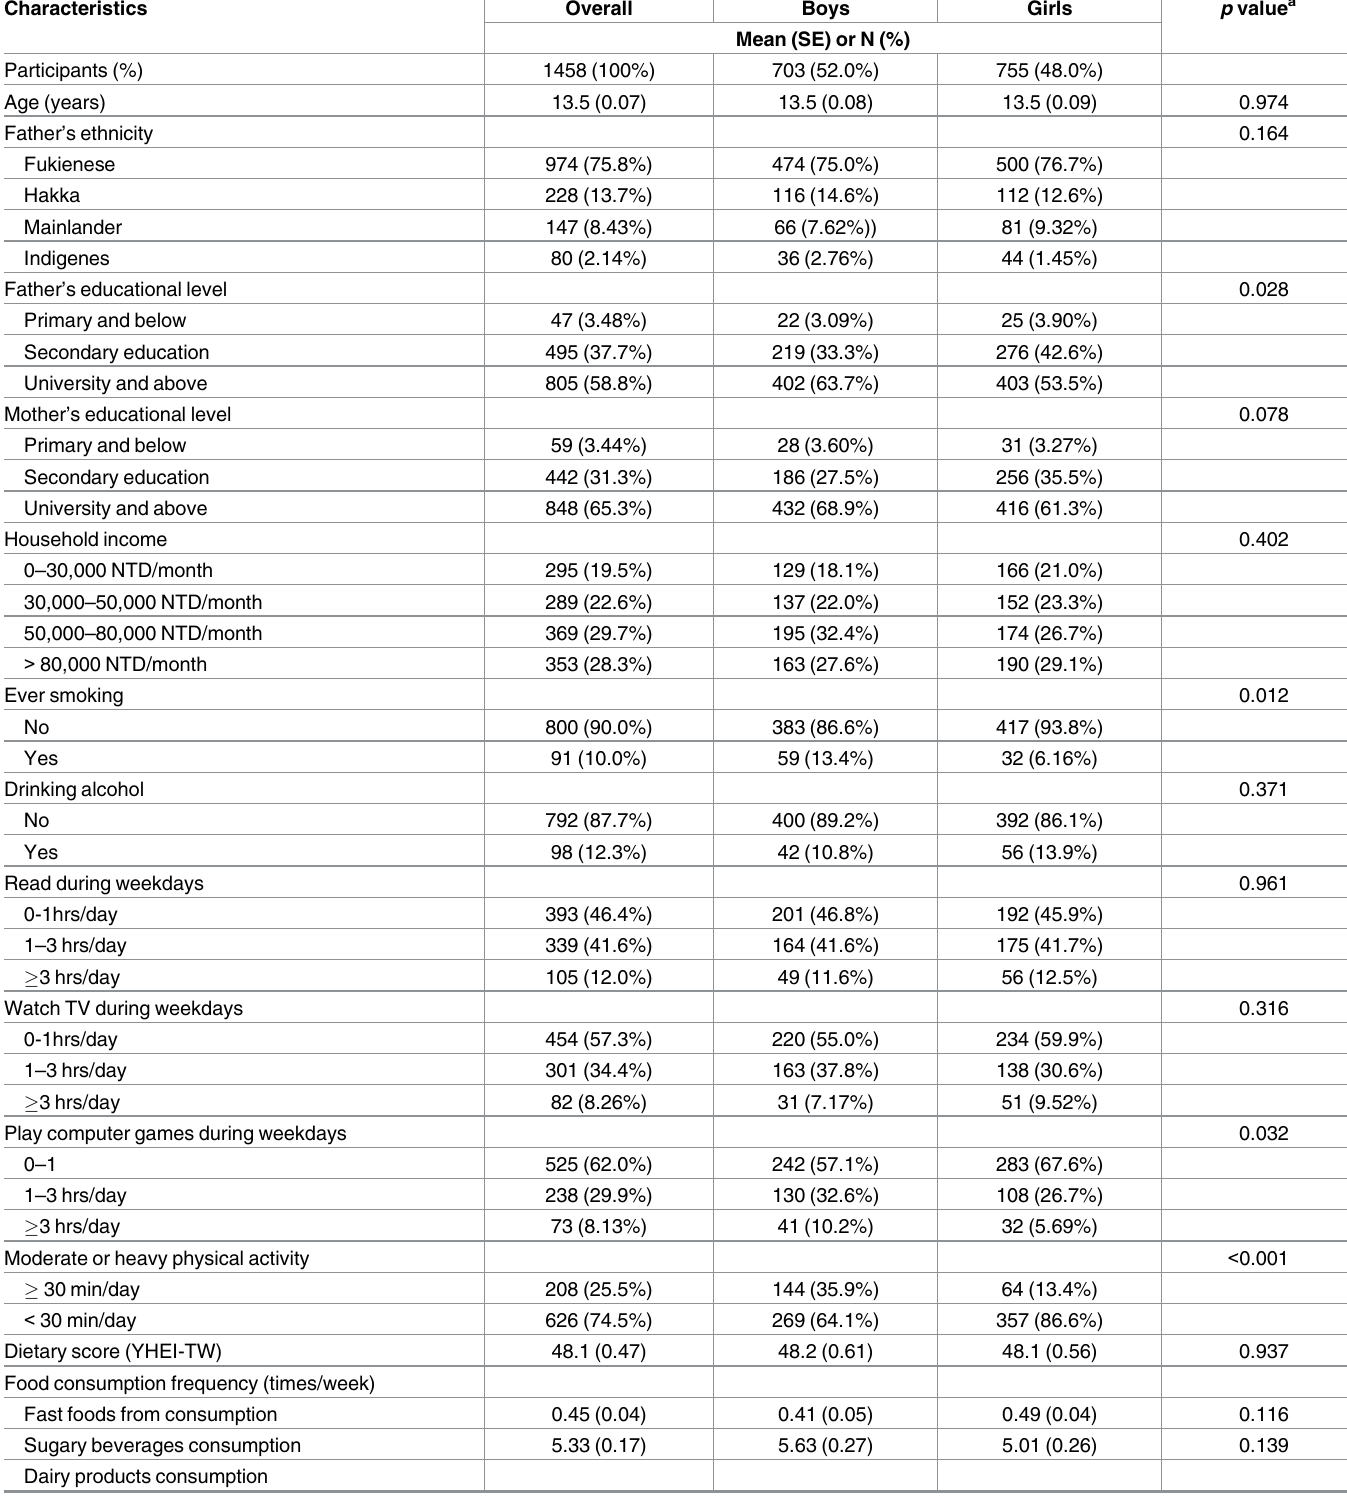
Table 1. Demographic characteristics of junior high school students by gender (N = 1458, 11–16years